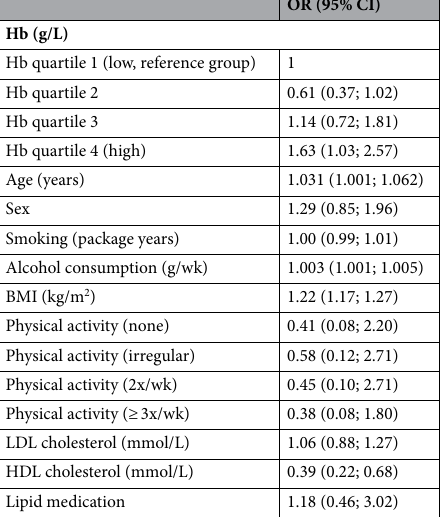
Table 2. Multivariable logistic regression risk model of liver fat accumulation. OR Odds Ratio with 95% Confidence Intervals (CIs). The regression model included all variables in the table.